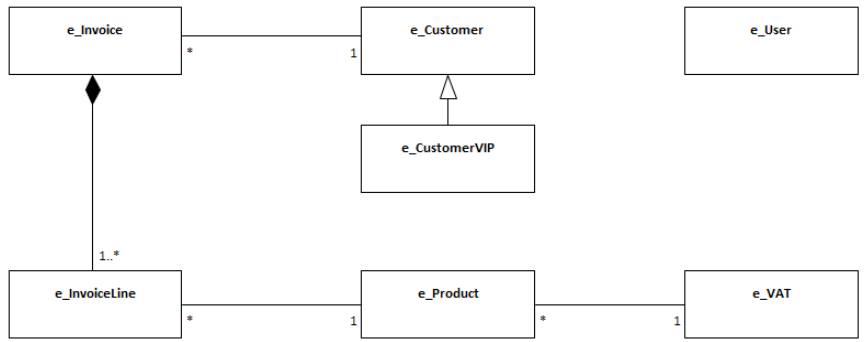
Figure 5. Domain model of the running example (UML notation).